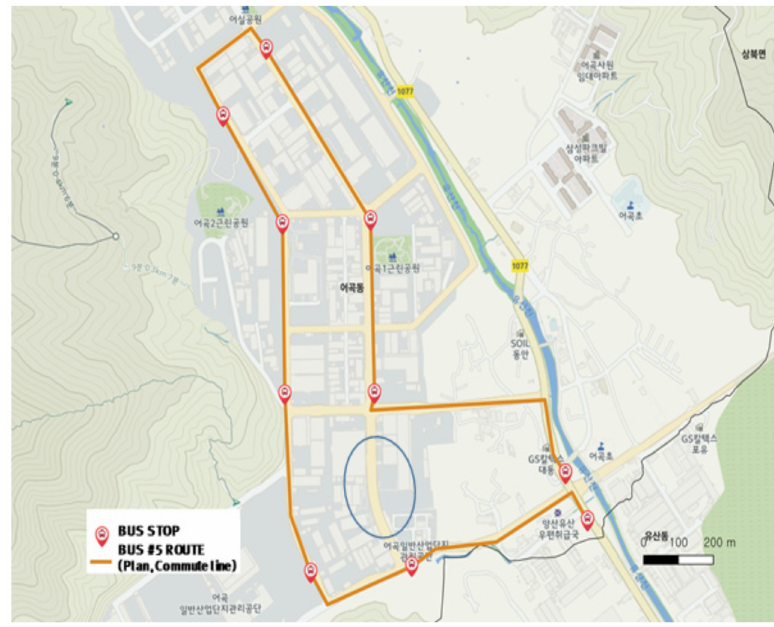
Figure 19. City-type bus No. 5 (commuting)